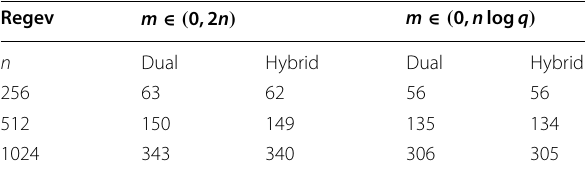
Table 3 (Hybrid) original dual attack